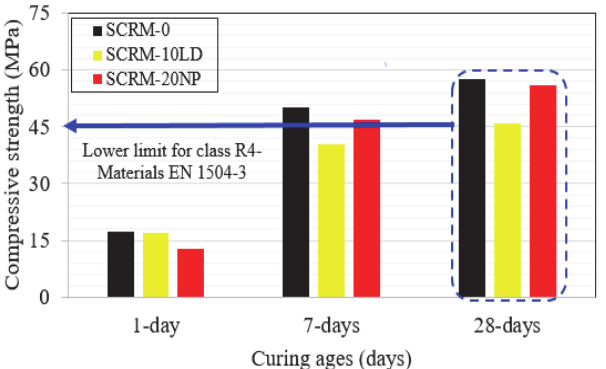
Figure 6: Variation of compressive strength with age for